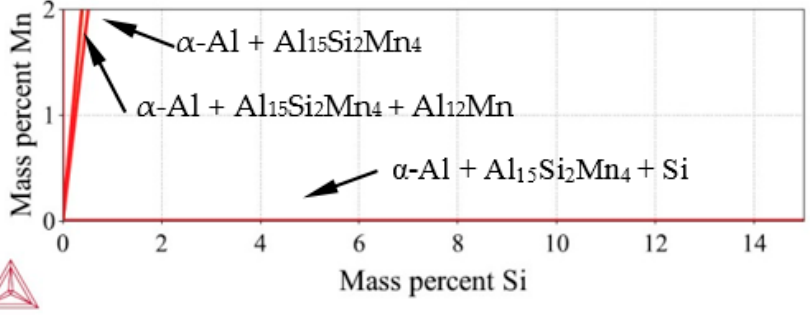
Figure 2. Ternary phase diagram—Al-Si-Mn system—Isothermal section at 20 °C.